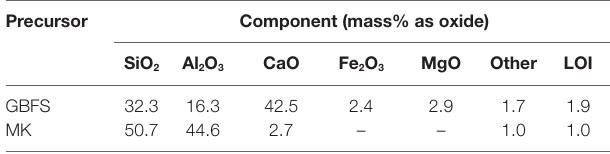
Table 1 | composition of the gbFs and MK used, determined through X-ray fluorescence